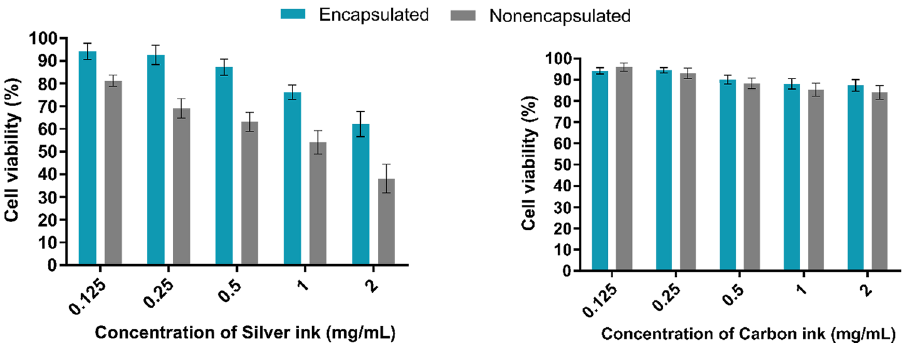
Figure 3. Toxicity assessment of the silver (left) and carbon inks (right) on the epidermal cell line HaCaT at varying concentrations. The x-axis represents the concentration of the ink (mg/ml) and the y-axis represents the cell viability (%). Bar graphs depict the cell viability assessed by MTT assay in response to the two inks after a 24 h exposure. All the data is depicted as mean ± SD from n = 3 independent